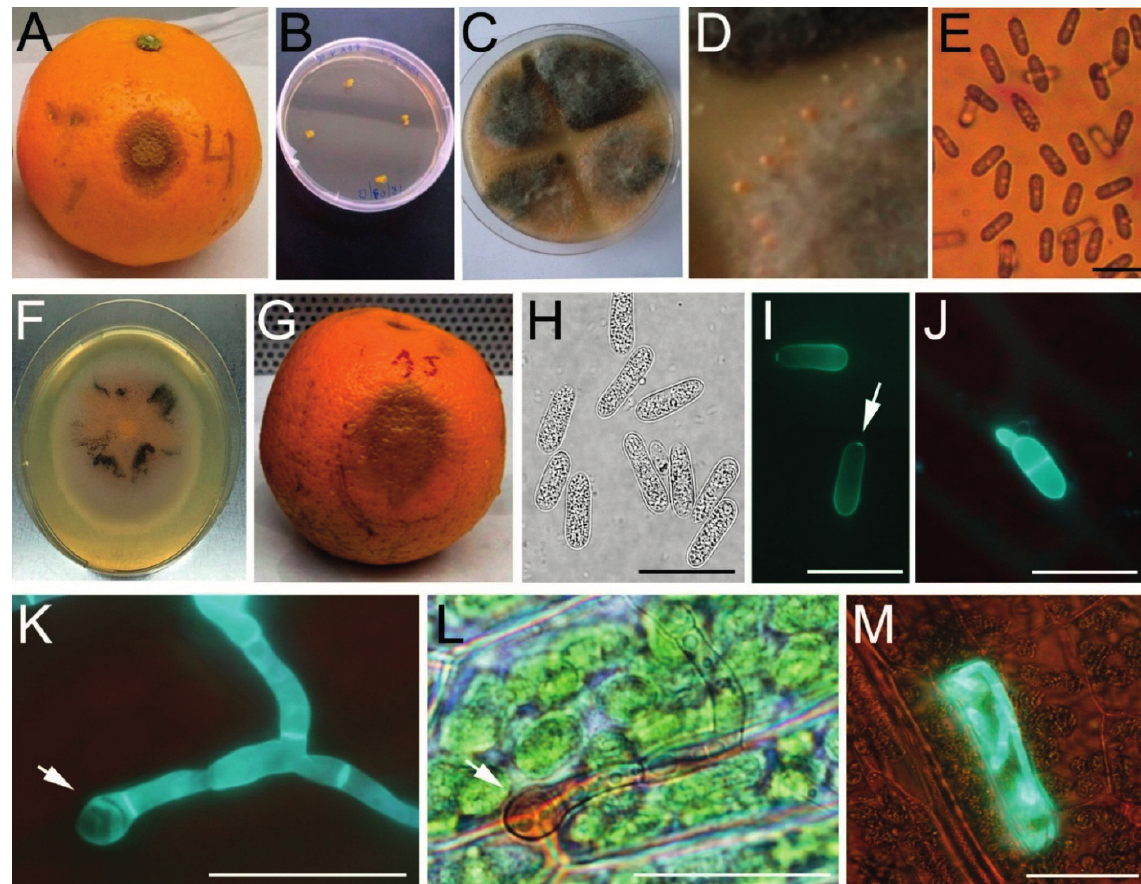
Figure 1. Isolation of C. gloeosporioides strain and infection of P. patens tissues. ( A ) Symptomatic citrus fruit; ( B ) Small pieces of symptomatic citrus lesion inoculated on Potato Dextrose Agar (PDA); ( C ) Mycelium grown from infected citrus lesion; ( D ) A closer view of C showing the acervuli; ( E ) Conidial suspension obtained from the orange mucilage; ( F ) Colony from monosporic conidial suspension; ( G ) Artificially inoculated citrus fruit; ( H , I ) C. gloeosporioides conidia morphology. Abscission scar of conidia is indicated with a white arrow in I ; ( J ) Germinated conidia on leaf surface showing germ tube and septa; ( K ) C. gloeosporioides hyphae growing on leaf surface stained with solophenyl; ( L ) Same picture as K showing brown mature appresorium. Appresorium is indicated with a white arrow in K and L ; ( M ) Intracellular growth of hyphae in moss leaf cell. Scale bars represent 20 μ m in E , H – L and 50 μ m in M